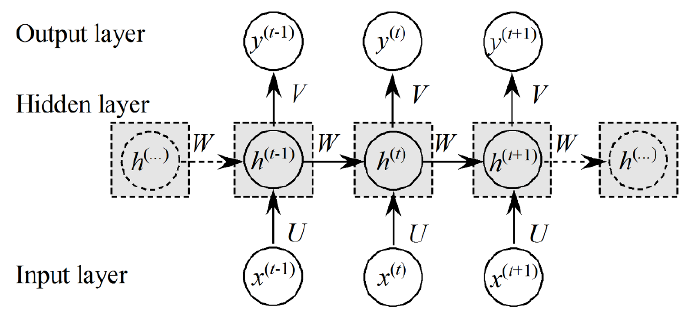
Figure 8. Basic architecture of an RNN module, showing shared parameters.